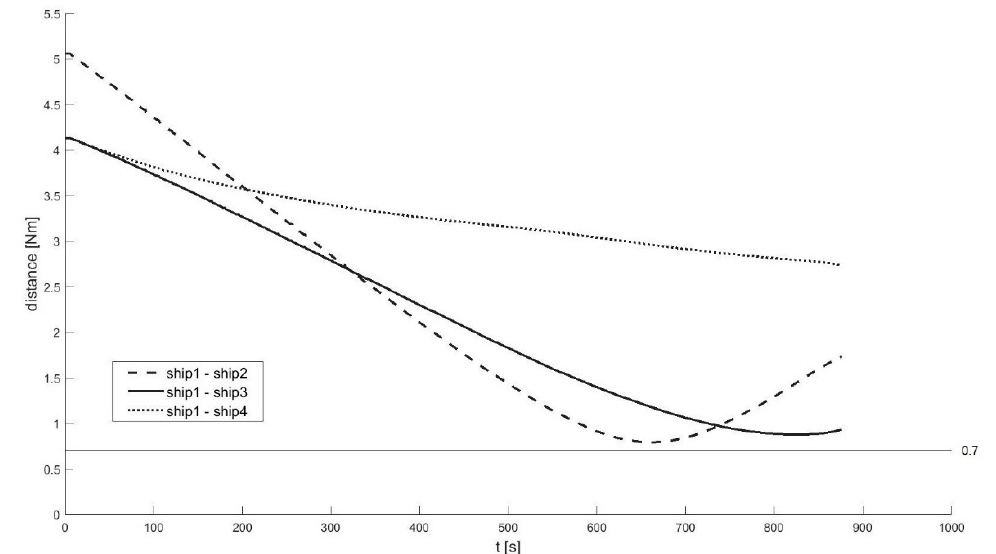
Figure 10. Execution of Scenario 1 with the anti-collision manoeuvre developed by Ship 1 — Distances between the ships.